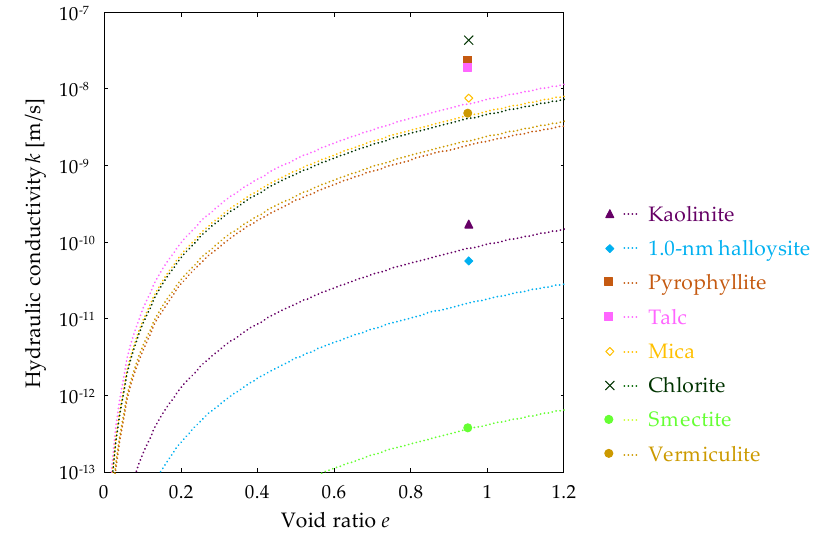
Figure 10. Relationship between void ratio and hydraulic conductivity of clay mineral samples. The dotted lines correspond to the values calculated using the Kozeny–Carman equation ([38,39]; Equation (3)).